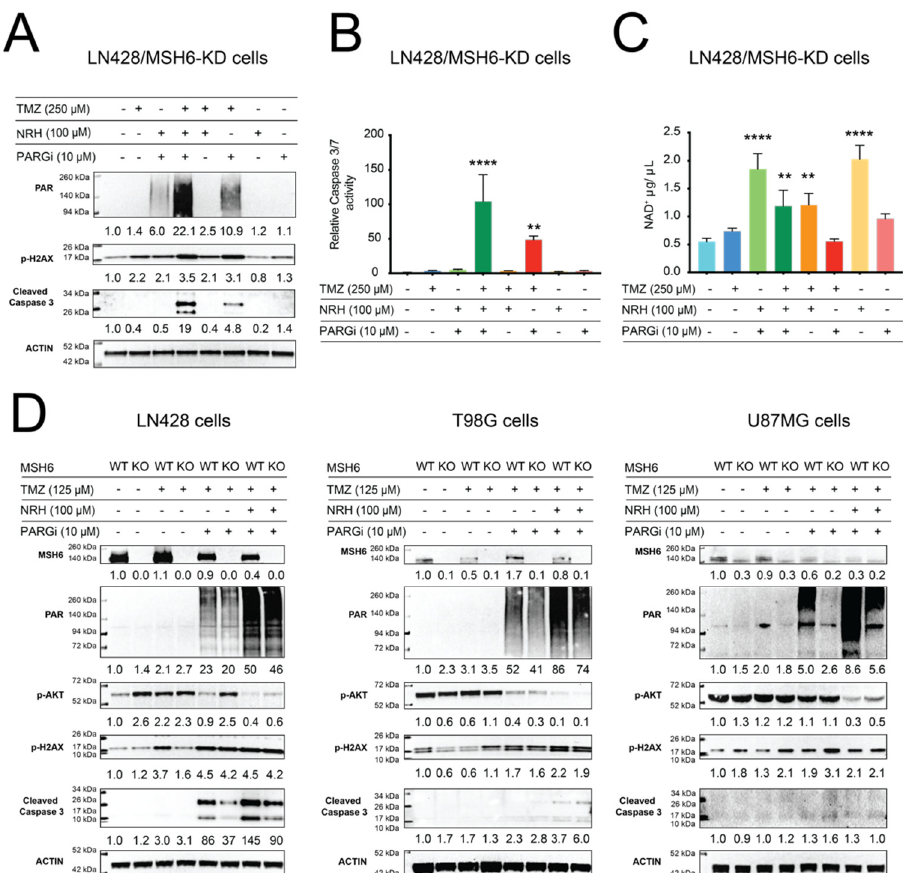
Figure 4. PAR accumulation suppresses cell survival signaling and induces apoptosis. ( A ) Im- munoblot analysis of total cell lysates for PAR, γ -H2AX, and cleaved caspase 3 at 24 h after treatment of LN428/MSH6-KD cells with DMSO, NRH (100 µ M), PARGi (10 µ M), N + P, TMZ (250 µ M), T + N, T + P, or T + N + P. β -Actin was used as the loading control. ( B ) Relative caspase 3/7 activity (LN428/MSH6-KD cells) 24 h after treatment with DMSO, NRH (100 µ M), PARGi (10 µ M), N + P, TMZ (250 μ M), T + N, T + P, or T + N + P; normalized to DMSO (** p < 0.01, **** p < 0.0001, one-way ANOVA). ( C ) Total cellular NAD + levels in LN428/MSH6-KD cells treated with DMSO, NRH (100 μ M), PARGi (10 μ M), N + P, TMZ (250 μ M), T + N, T + P, or T + N + P for 24 h, normalized to DMSO (** p < 0.01, **** p < 0.0001, one-way ANOVA). ( D ) Immunoblot analysis of total cell lysates for MSH6, PAR, p-AKT, γ -H2AX, and cleaved caspase 3, 24 h after treatment of MSH6-WT or MSH6-KO from LN428, T98G, or U87MG cells treated with DMSO, TMZ (125 µ M), T + P, or T + N + P. β -Actin was used as the loading